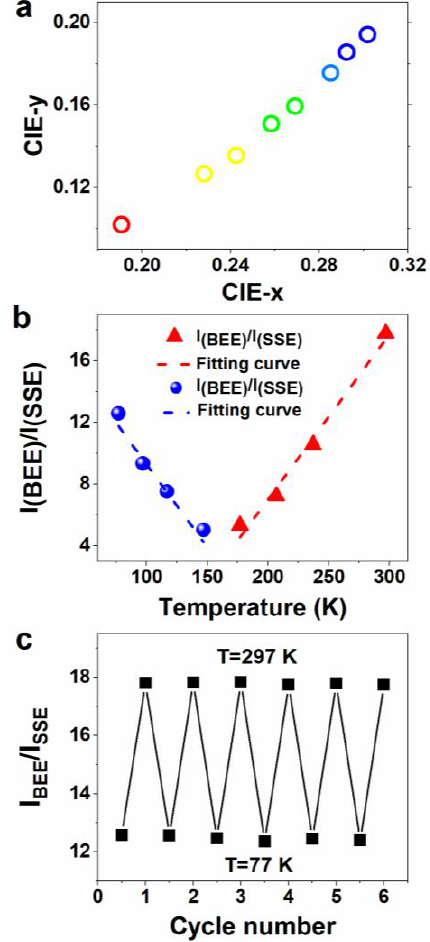
Figure 4. ( a ) Temperature-dependent emission from the CdS /ZnS core/shell QDs shown in Figure 2 projected onto the Commission Internationale del’É clairage (CIE) chromaticity diagram; ( b ) ratio of integral PL peak areas of BEE and SSE; and ( c ) thermal stability of the integrated BEE and SSE PL peak area ratio over six cycles of heating and cooling between 77 – 297 K.